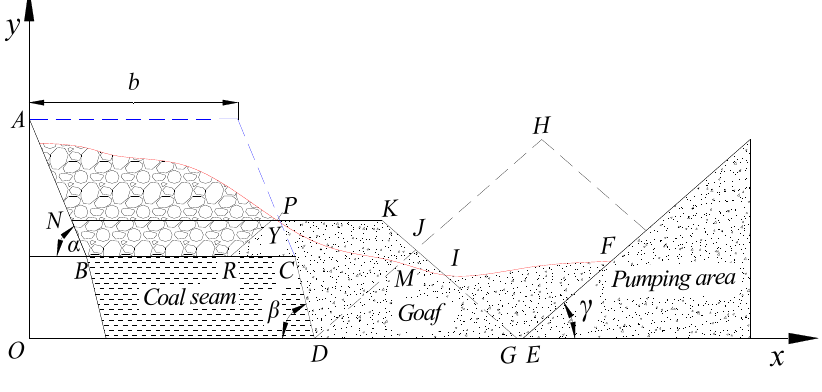
Figure 5. Numerical model of cast blasting stockpile profile.